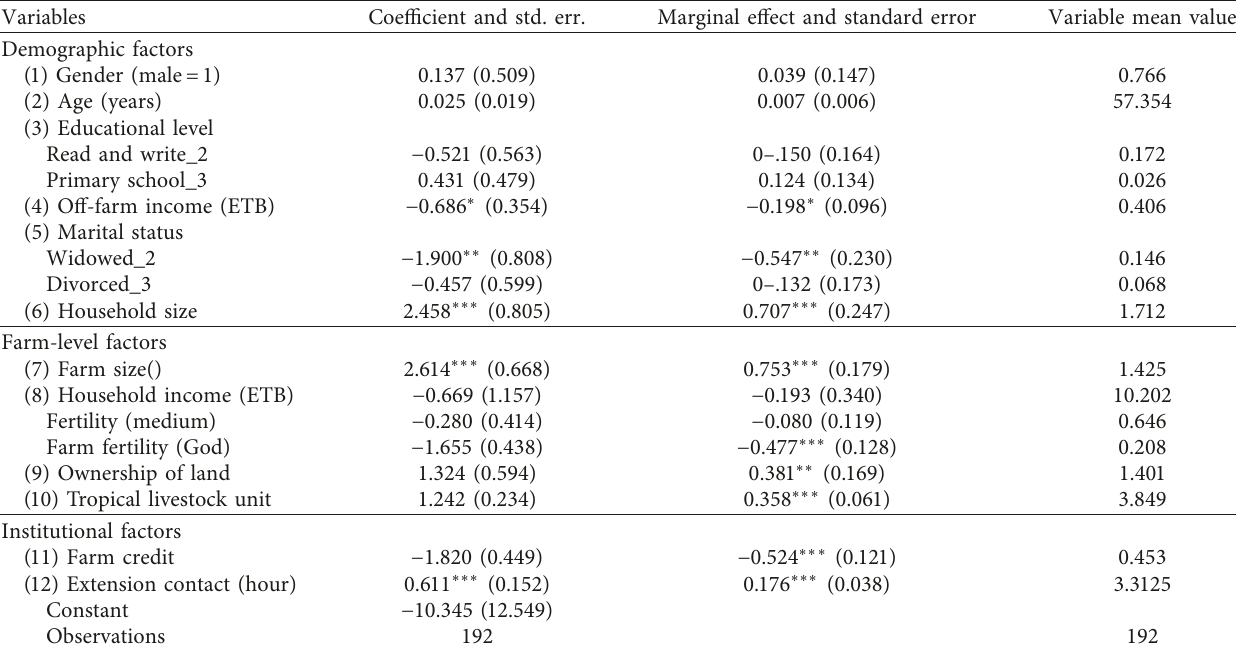
Table 3: Determinants of adoption decision of organic fertilizer. Variables Coefficient and std.